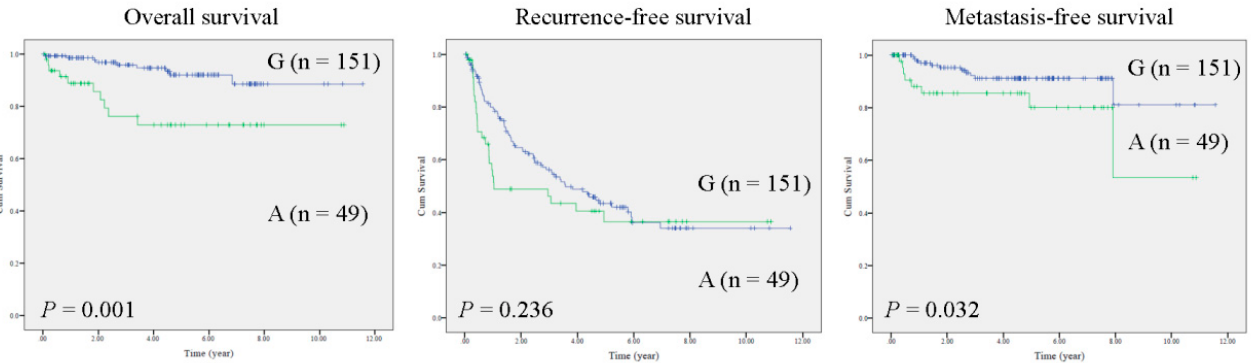
Figure 1. MT-RNR1 709A predicts poor prognosis in HCC. Kaplan–Meier analysis of survival outcome based on MT-RNR1 709G (G) or 709A (A) in HCC specimens ( n = 200). Survival outcome was analyzed using the log-rank test.